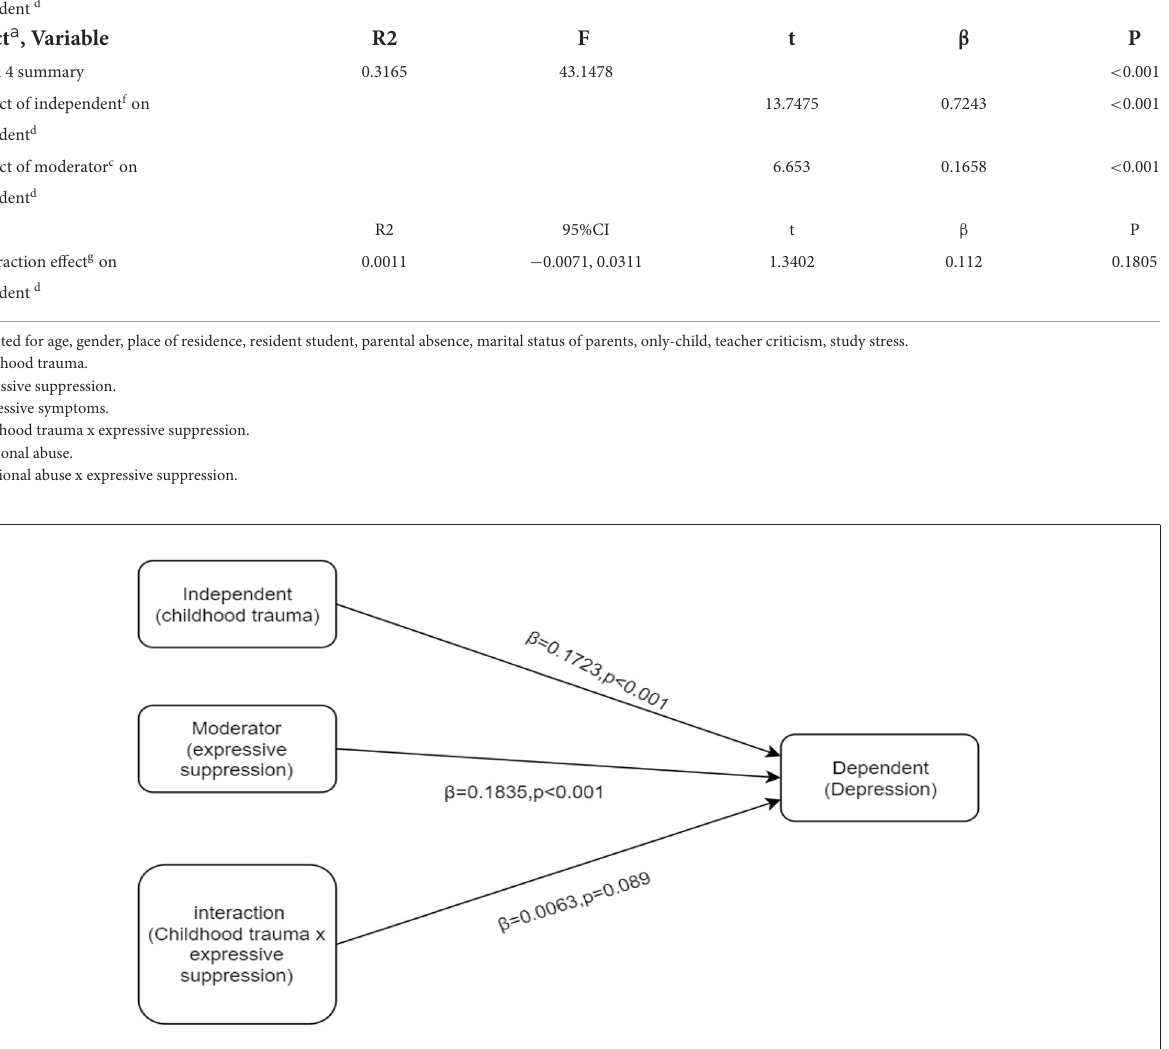
FIGURE2 Output model of expressive suppression